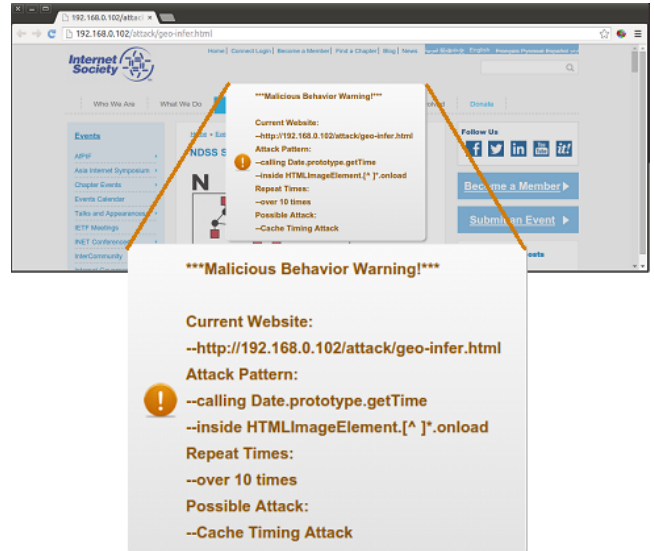
Figure 5. Given a malicious website, once the probing behavior detector finds suspicious behaviors, it raises an alert to warn the